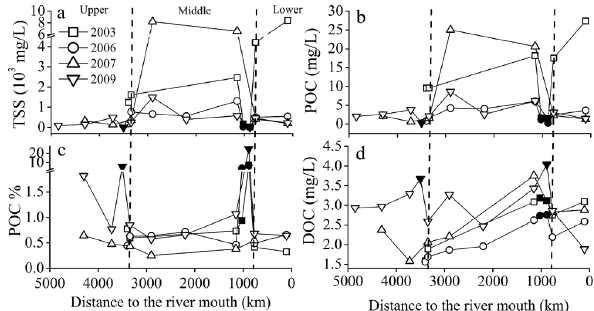
Fig. 2. Spatial and temporal variations of TSS (a) , POC (b) , POC% (c) and DOC (d) along the mainstream of the Yellow River (solid symbols represent data from the reservoirs). The upper reach is located above the Lanzhou station while the middle reach is situ- ated between the Lanzhou station and the Huayuankou station. The reach below the Huayuankou station is considered the lower